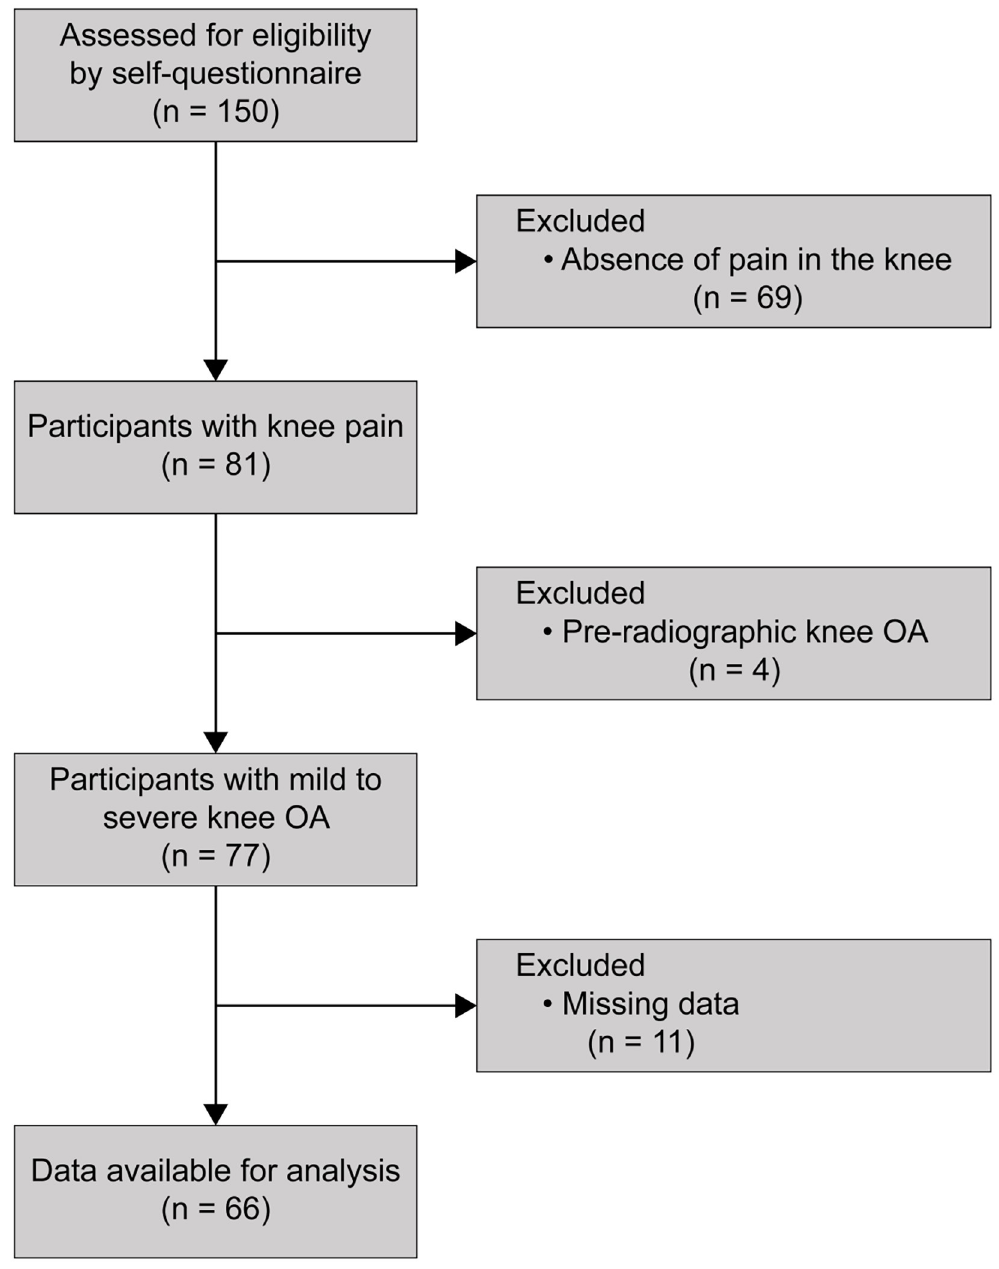
Fig 1. Flow diagram of the study